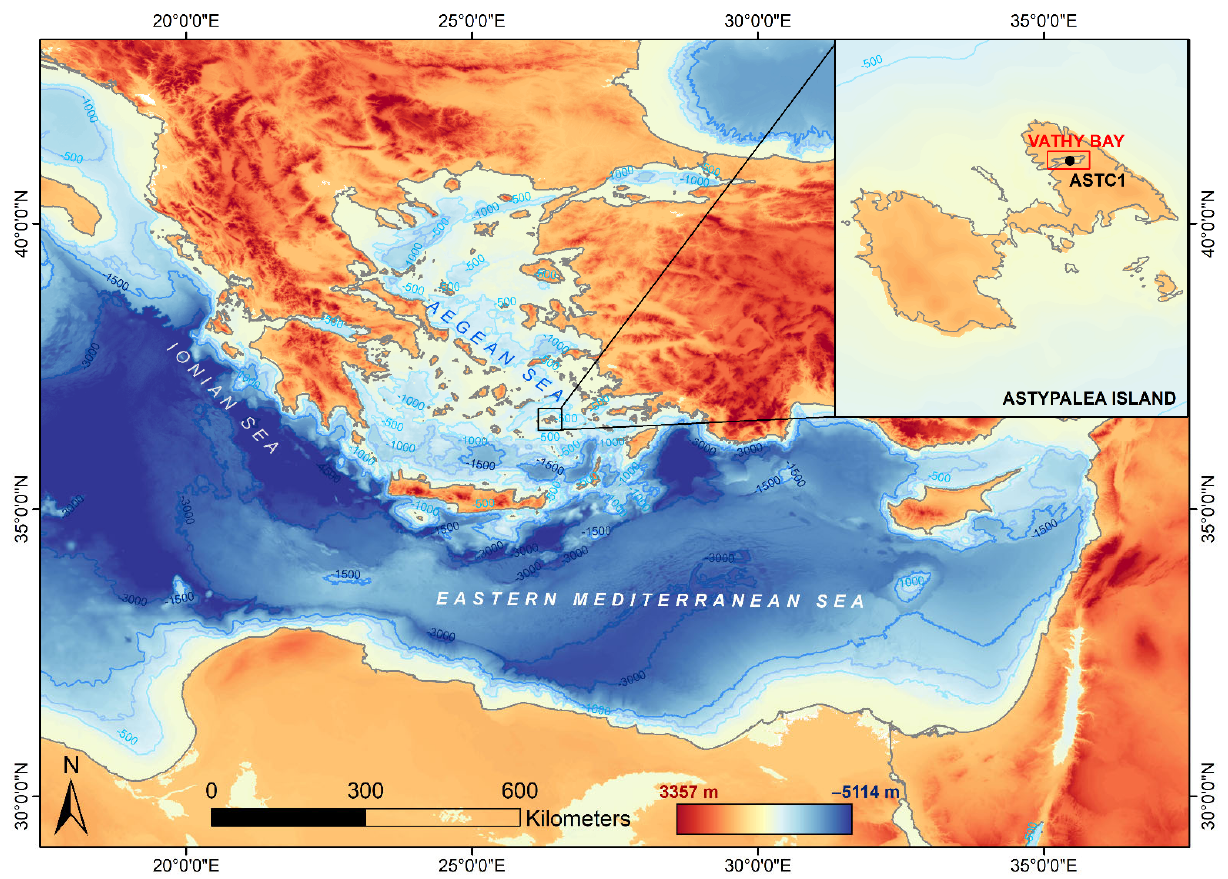
Figure 1. Map of the Eastern Mediterranean region, the location of the study site, and sediment core ASTC1. The bathymetric data were obtained from GEBCO (https://download.gebco.net (accessed on 15 January 2021)).